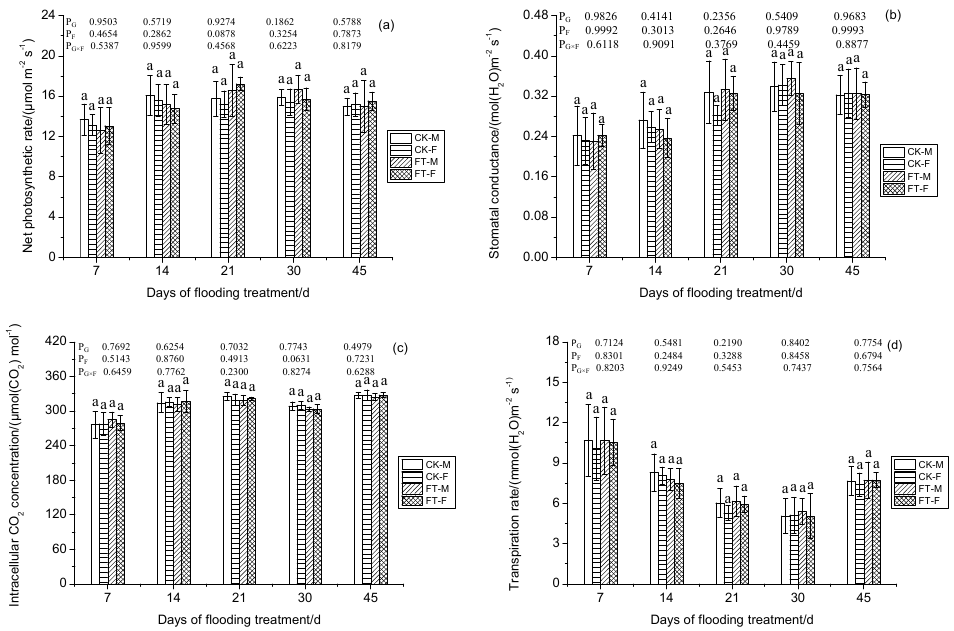
Figure 4. Net photosynthesis rate (P n ) ( a ), stomatal conductance (g s ) ( b ), intracellular CO 2 concentration (C i ) ( c ), and transpiration rate (E) ( d ) of male vs. female Salix viminalis plants at di ff erent times of flooding treatment.